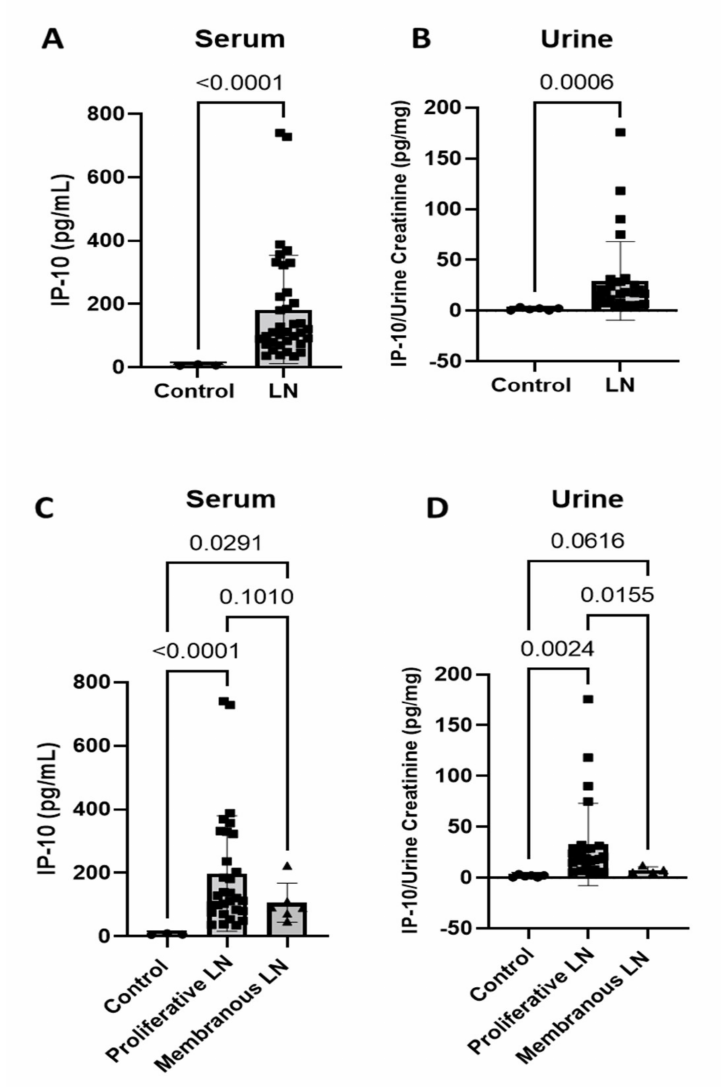
Figure 1. IP-10 is increased in serum and urine of LN patients. ( A ) Serum; and ( B ) urine levels of IP-10 of active LN samples are increased compared to healthy individuals (control) (serum, n = 3, n = 36; urine, n = 6, n = 29; Two-Tailed T-Test with Welch’s correction); ( C ) Serum; and ( D ) urine IP-10 levels in patients with active proliferative LN and membranous LN compared to control. In serum, both proliferative and membranous LN IP-10 levels were increased compared to control (serum, n = 3, n = 30, n = 6; Brown–Forsythe and Welch ANOVA Test, multiple comparisons). In urine, IP-10 levels were only increased in proliferative LN. (urine = 6, n = 25, n = 4; Brown–Forsythe and Welch ANOVA Test, multiple